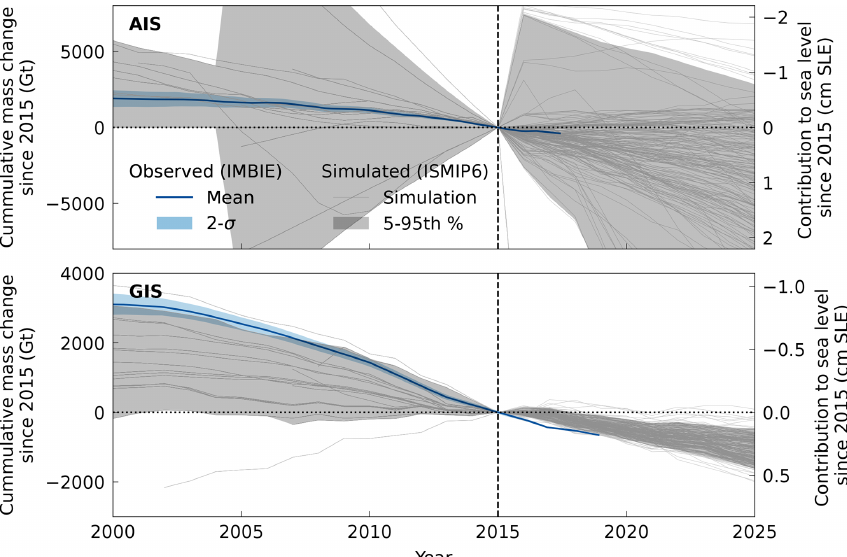
Figure 2. Observed and simulated historical mass changes from the Antarctic ice sheet (AIS) and Greenland ice sheet (GIS) between 2000 and 2020 in gigatons (Gt) and centimeters of sea level equivalent (cmSLE). A consensus estimate of observed mass changes (The IMBIE team, 2018; The IMBIE Team, 2019) is plotted in blue along with their respective uncertainties (shaded). The ensembles of ISMIP6 (Goelzer et al., 2020; Seroussi et al., 2020) historical simulations and projections are plotted with dark-gray lines, and the 5th to 95th percentile mass loss rates are shown as a 90% credibility interval with light-gray shading. Here the control simulation was removed, in alignment with Seroussi et al. (2020) and Goelzer et al.